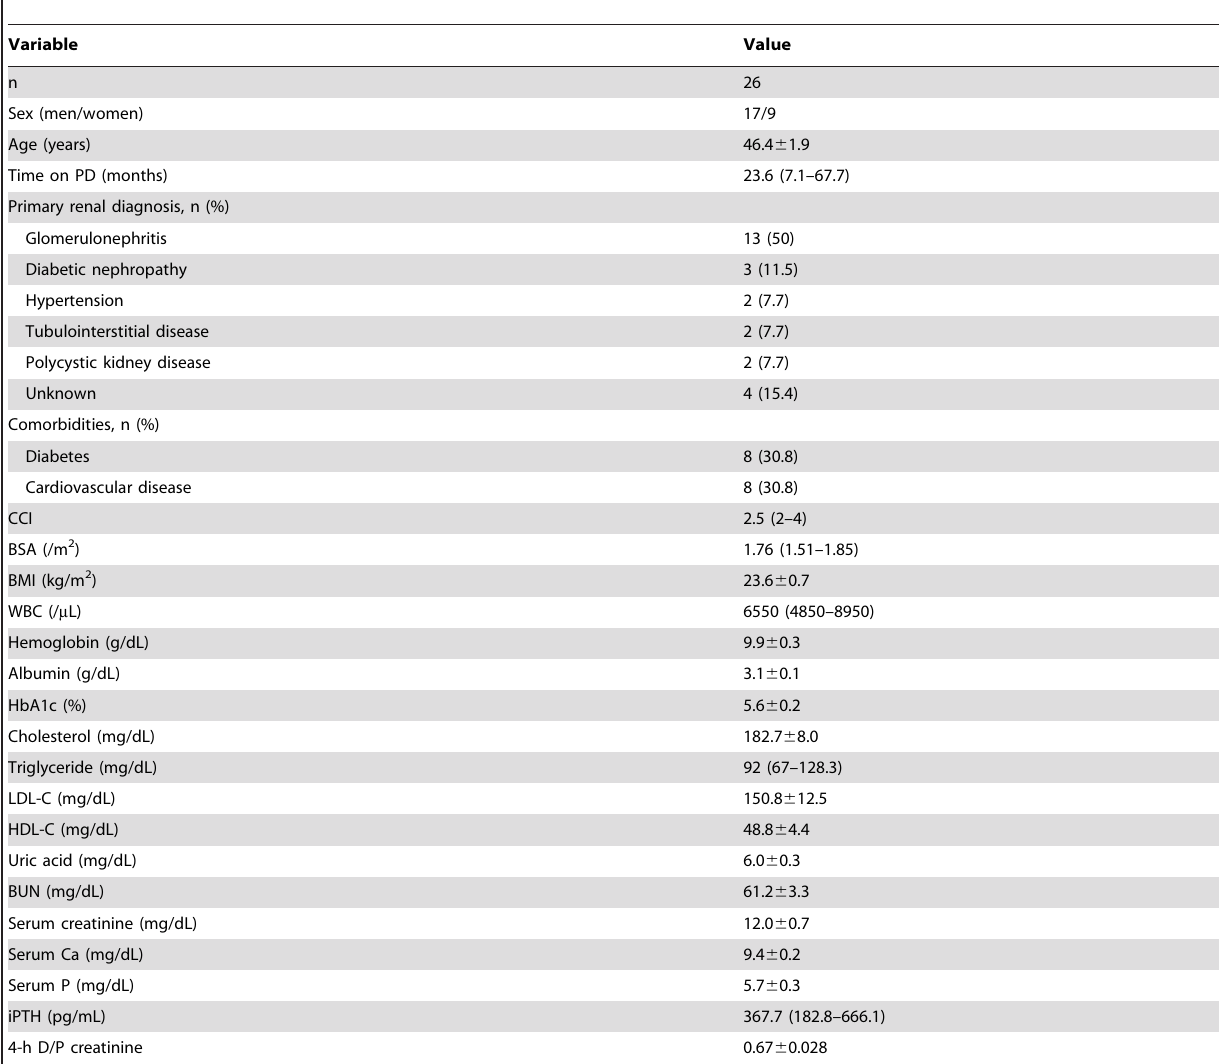
Table 1. Demographics and clinical characteristics of the study